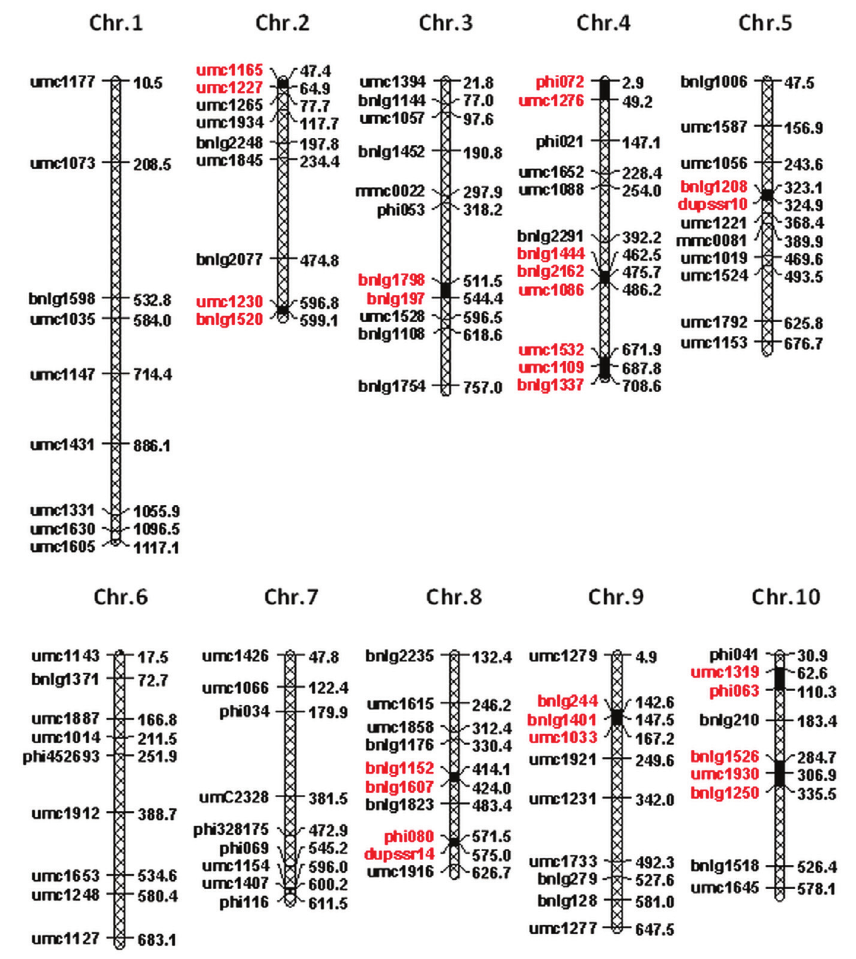
Figure1 -Microsatellitemarkers(99)utilizedfordemarcationofinformativechromosomesamongtropicalsweetcorninbredlines,andtheirlocationsin thegenome.DistancesareshownincentiMorganunits(cM),microsatellitesinredareatdisequilibrium,andDarkspotsonchromosomesindicate hotLD blocks with pairs of alleles in LD from different loci separated less than 50 cM on the same